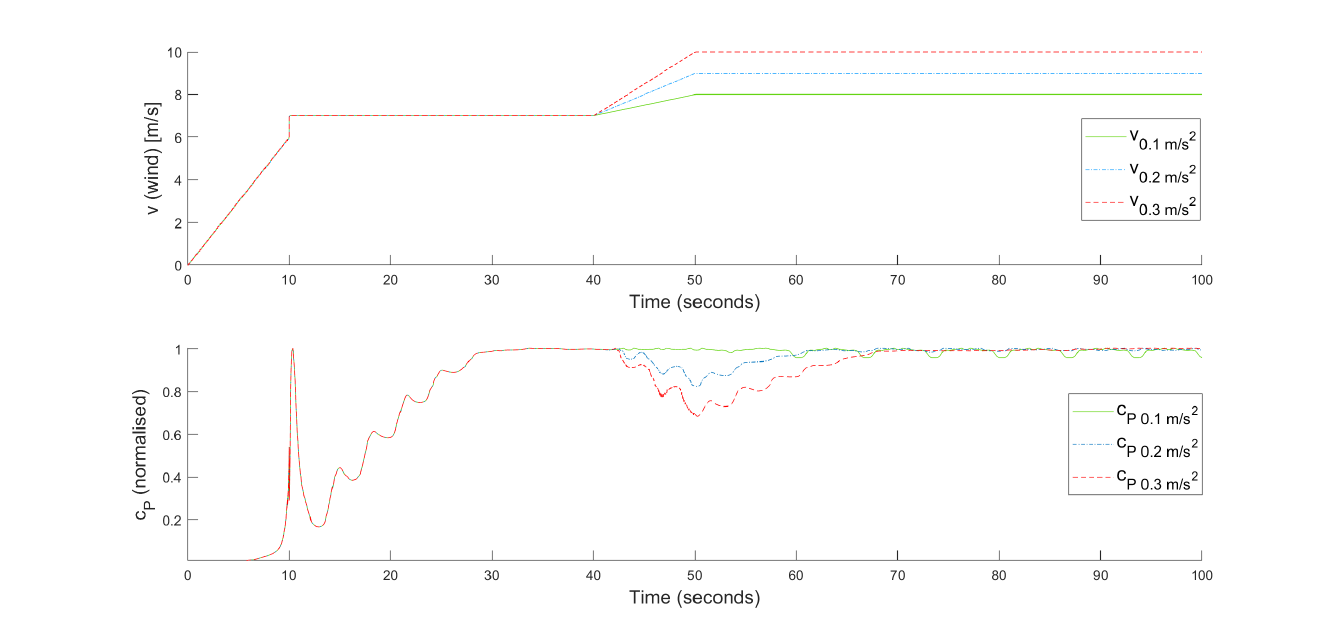
Figure 5. Response of the extremum seeking controller for slow (green and solid) and faster (blue or red, and dashed) wind